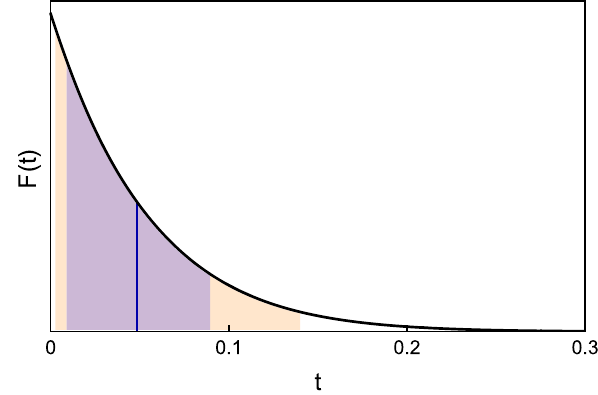
Fig. 1 Distribution of the hyperparameter t as given by Eq. (5). The vertical blue line corresponds to the central value ¯ t , the blue shaded area to the 68% CL evaluated from the upper/lower bound of the integral of F ( t ) . The orange shaded area corresponds to the 95% CL. The y -axis has arbitrary